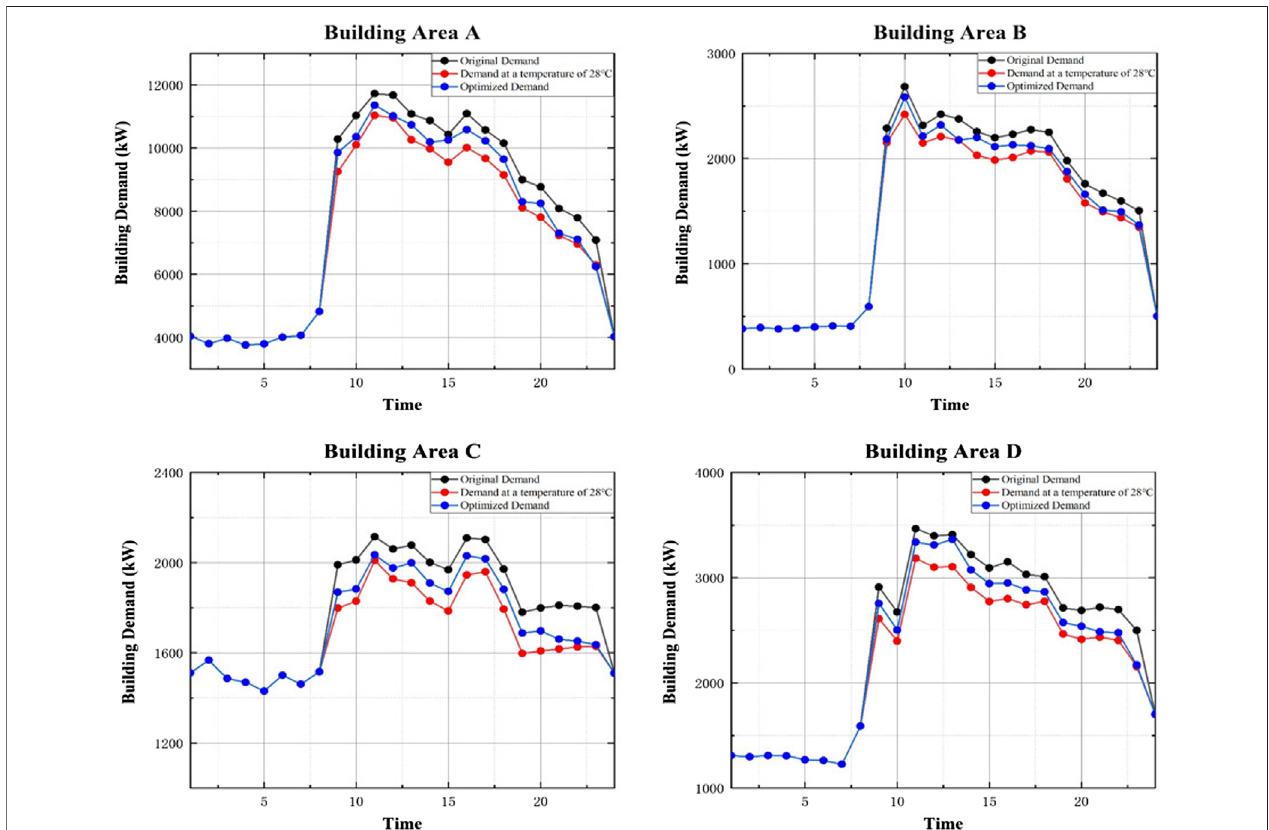
FIGURE 5 | Optimized demand pro fi les of four areas of passive storage buildings.